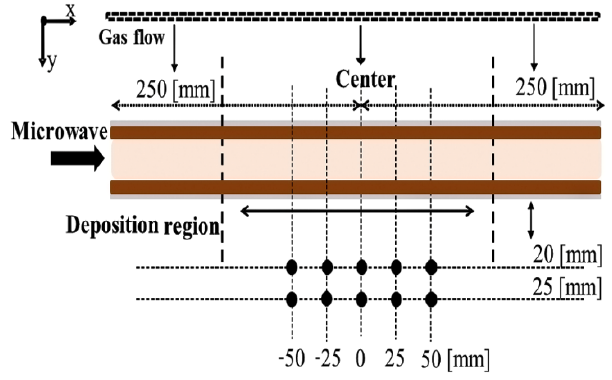
Figure 5. Diagnostic setup in the deposition region.